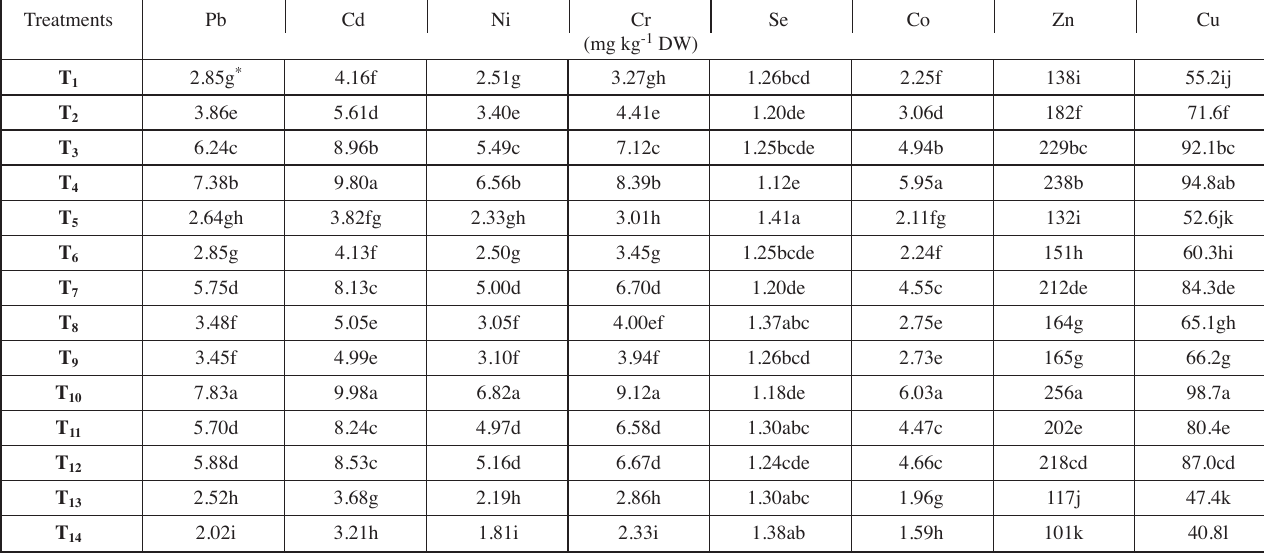
Tab. 5: Effect of N-fertilizer form applications on the concentrations of heavy metals [lead (Pb), cadmium (Cd), nickel (Ni), chromium (Cr), selenium (Se), cobalt (Co), zinc (Zn), and copper (Cu)] in shoots of wheat plants grown under saline soil conditions Treatments